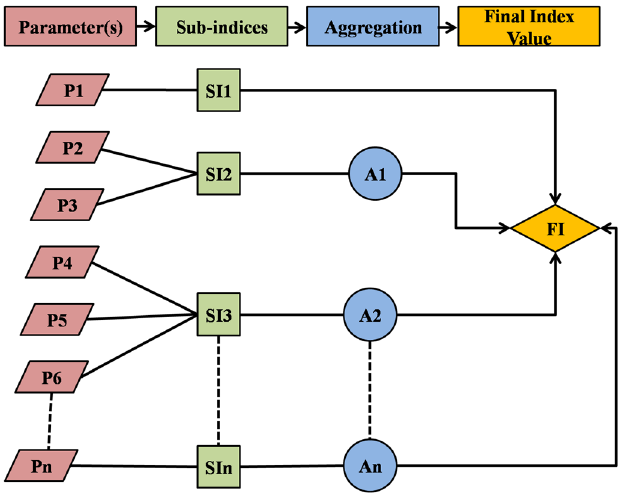
Figure 2. This figure is showing the common structure of the WQI.